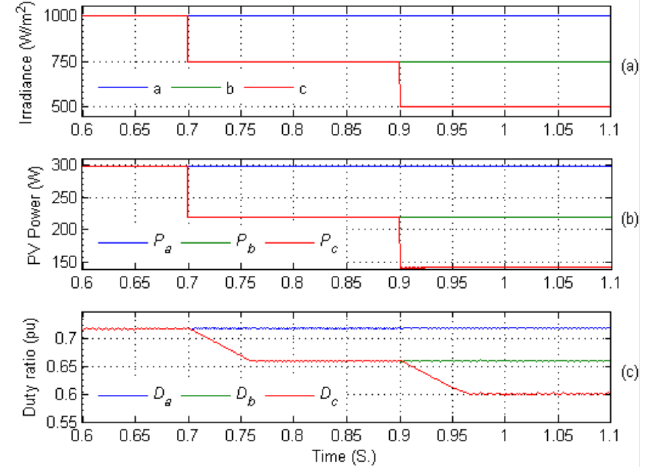
Figure 6. Results of the proposed HFMP converter with three photovoltaic modules. ( a ) Irradiance levels. ( b ) Output PV power. ( c ) Duty cycles.